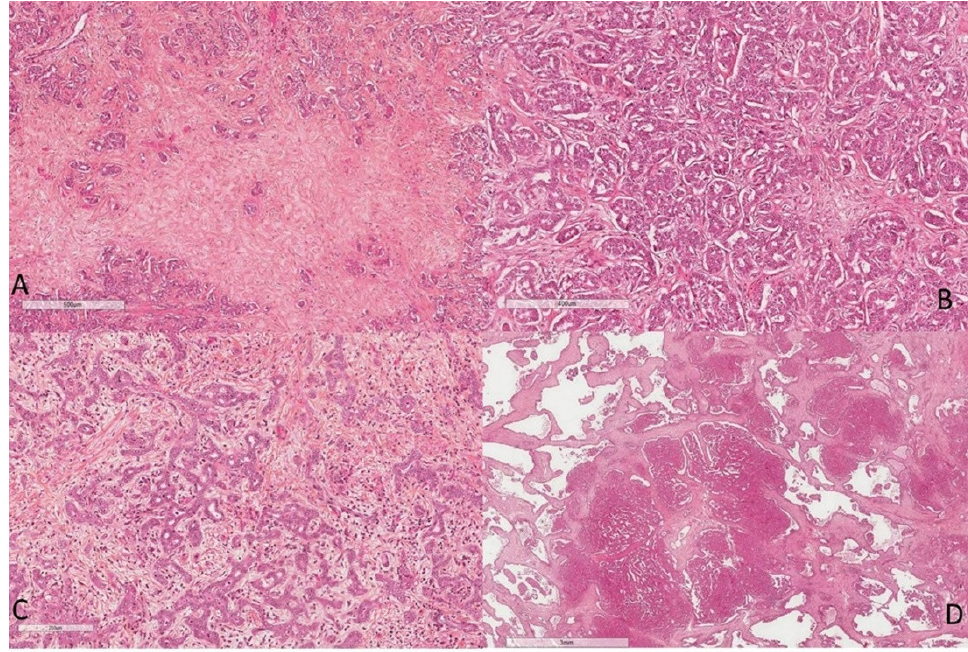
Figure 3. Microscopic aspects of intrahepatic cholangiocarcinoma: ( A ) presence of a desmoplastic stroma, ( B ) small duct type, ( C ) cholangiolocarcinoma, and ( D ) ductal plate cholangiocarcinoma (HES staining ×100).